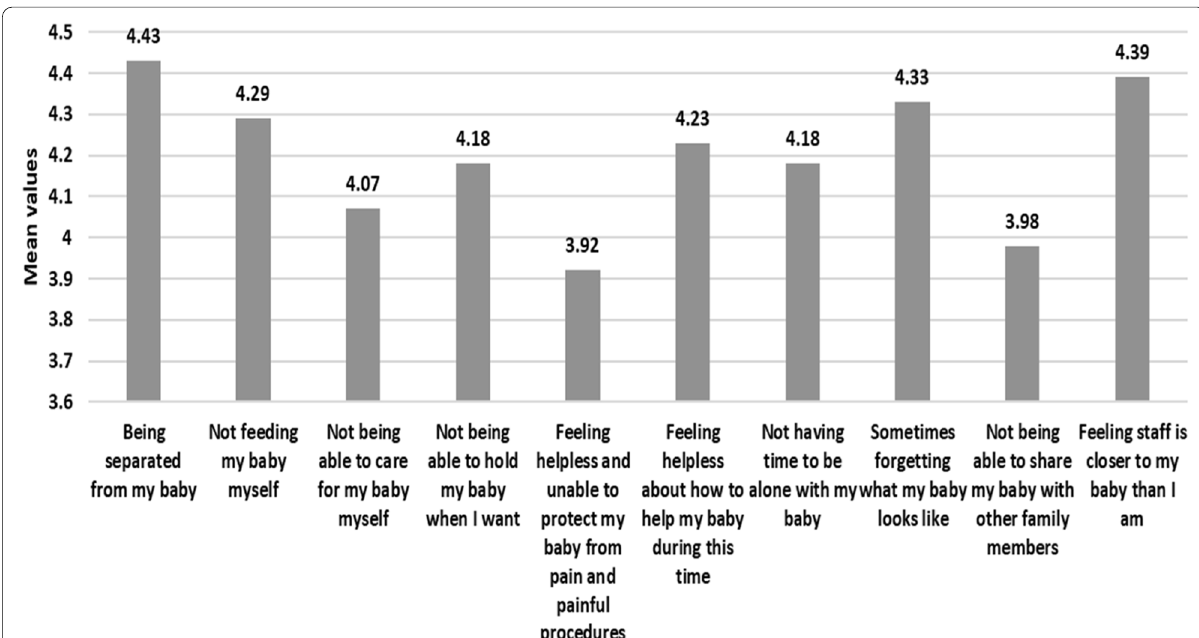
Fig. 3 Mean Stress Scores of each component of Parental role and Relationship domain (domain 3) of PSS: NICU